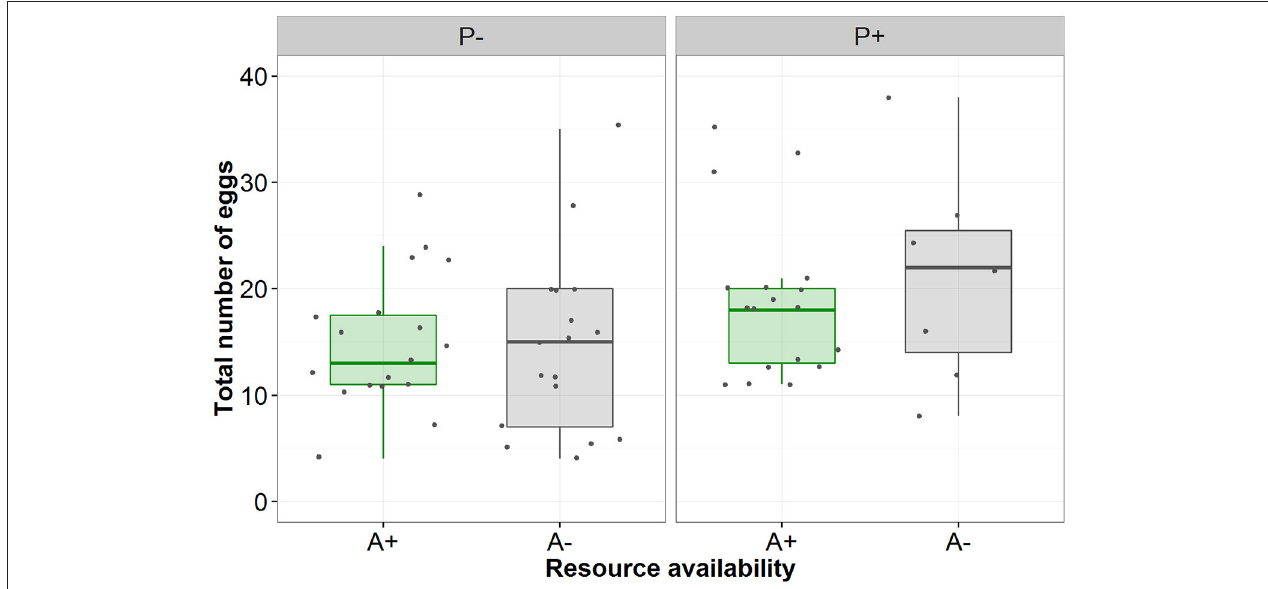
FIGURE 2 | The total number of eggs laid by females under conditions of no perceived predation risk (P − ) or perceived predation risk (P + ) and aphid presence (green/A + ) or absence (gray/A −